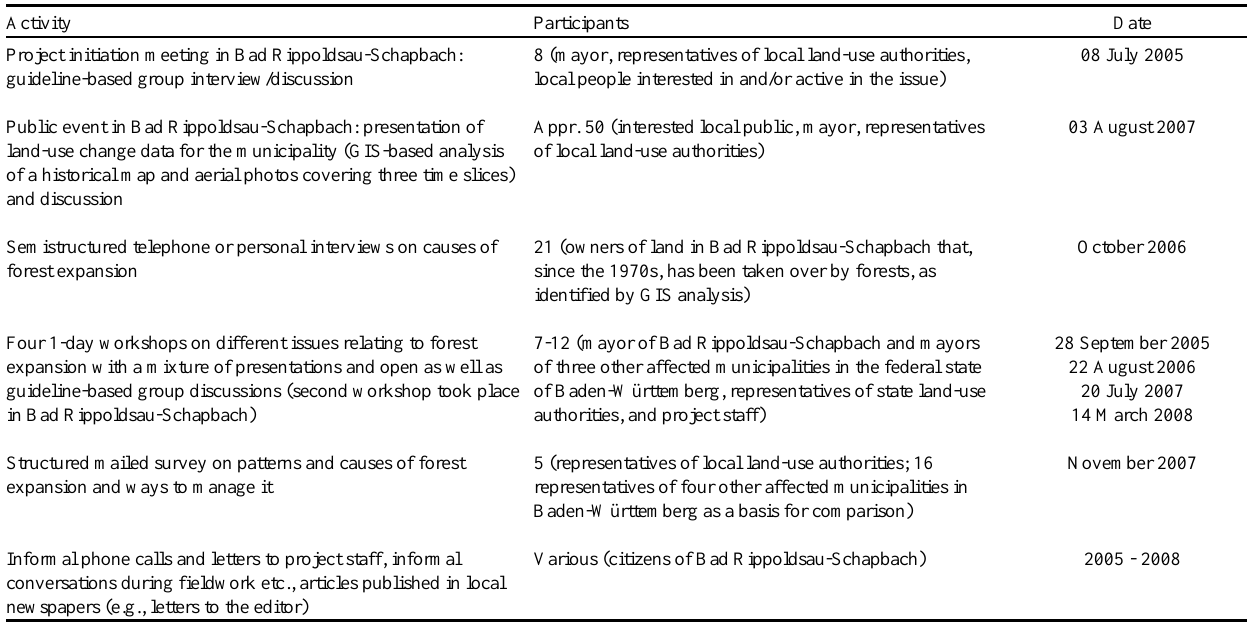
Table 1 . Data sources used for the analysis of the perception of, and responses to, landscape change in Bad Rippoldsau-Schapbach.